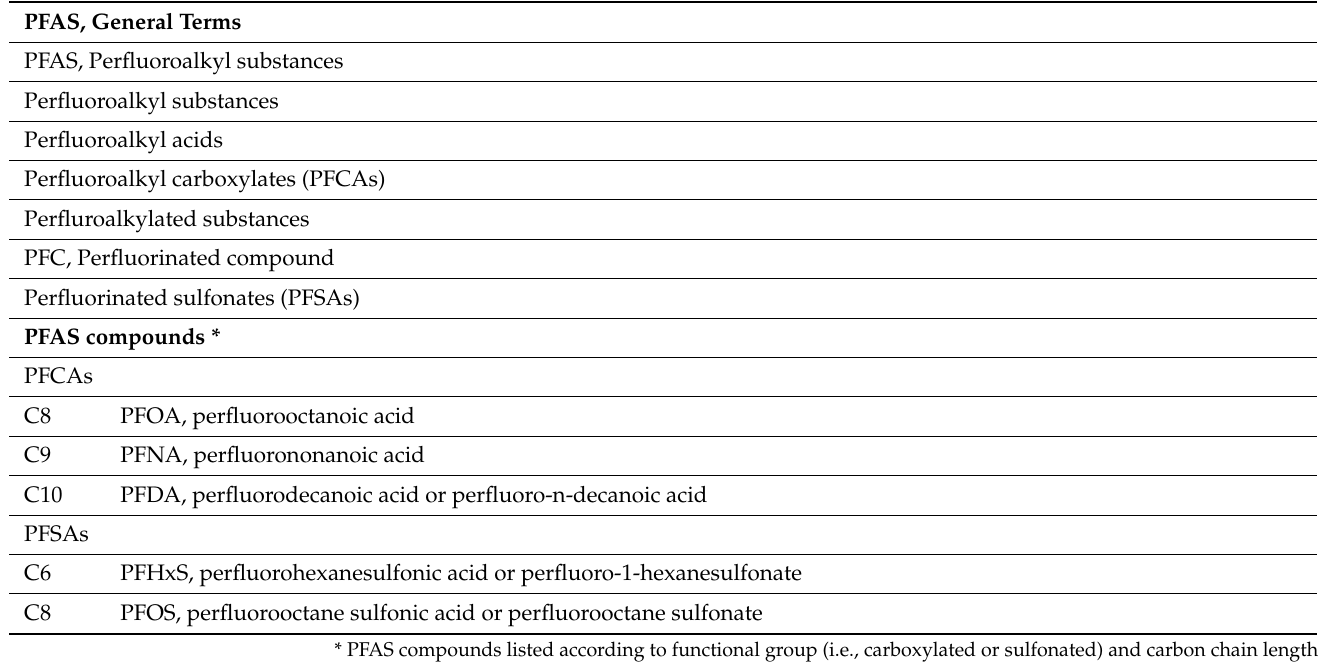
Table 3. Search terms on